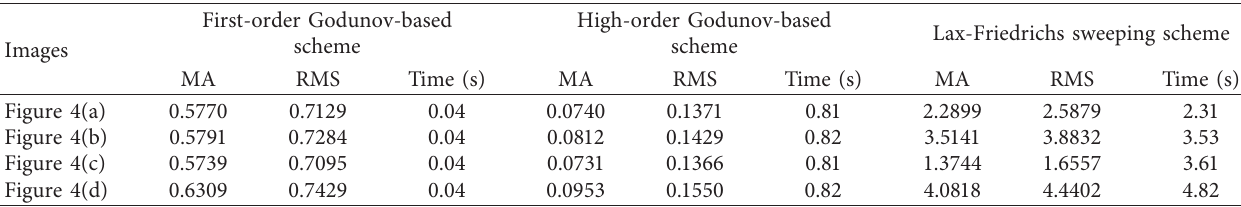
Table 3: Quantitative comparisons of schemes for the synthetic vase images.